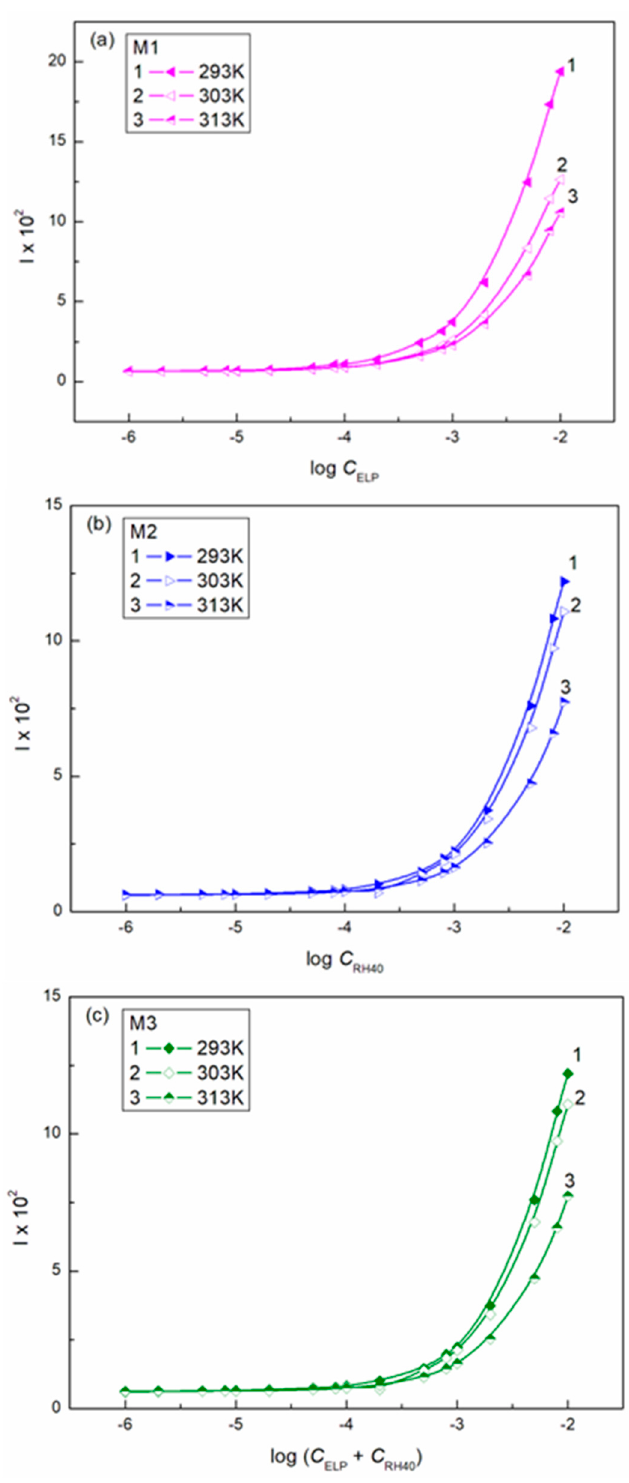
Figure 7. A plot of the fl uorescence intensity ( 𝐼 ) of mixtures M1 ( a ), M2 ( b ), and M3 ( c ) vs. the logarithm of the surfactant or their mixture concentration at a constant temperature equal to 293 K (curve 1), 303 K (curve 2), and 313 K (curve 3).